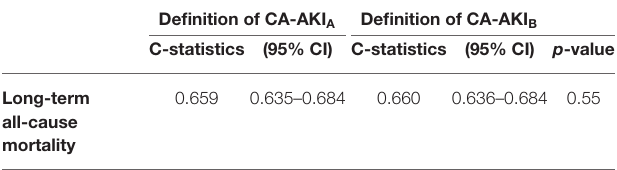
TABLE 3 | C-statistics for two multivariate Cox proportional hazards